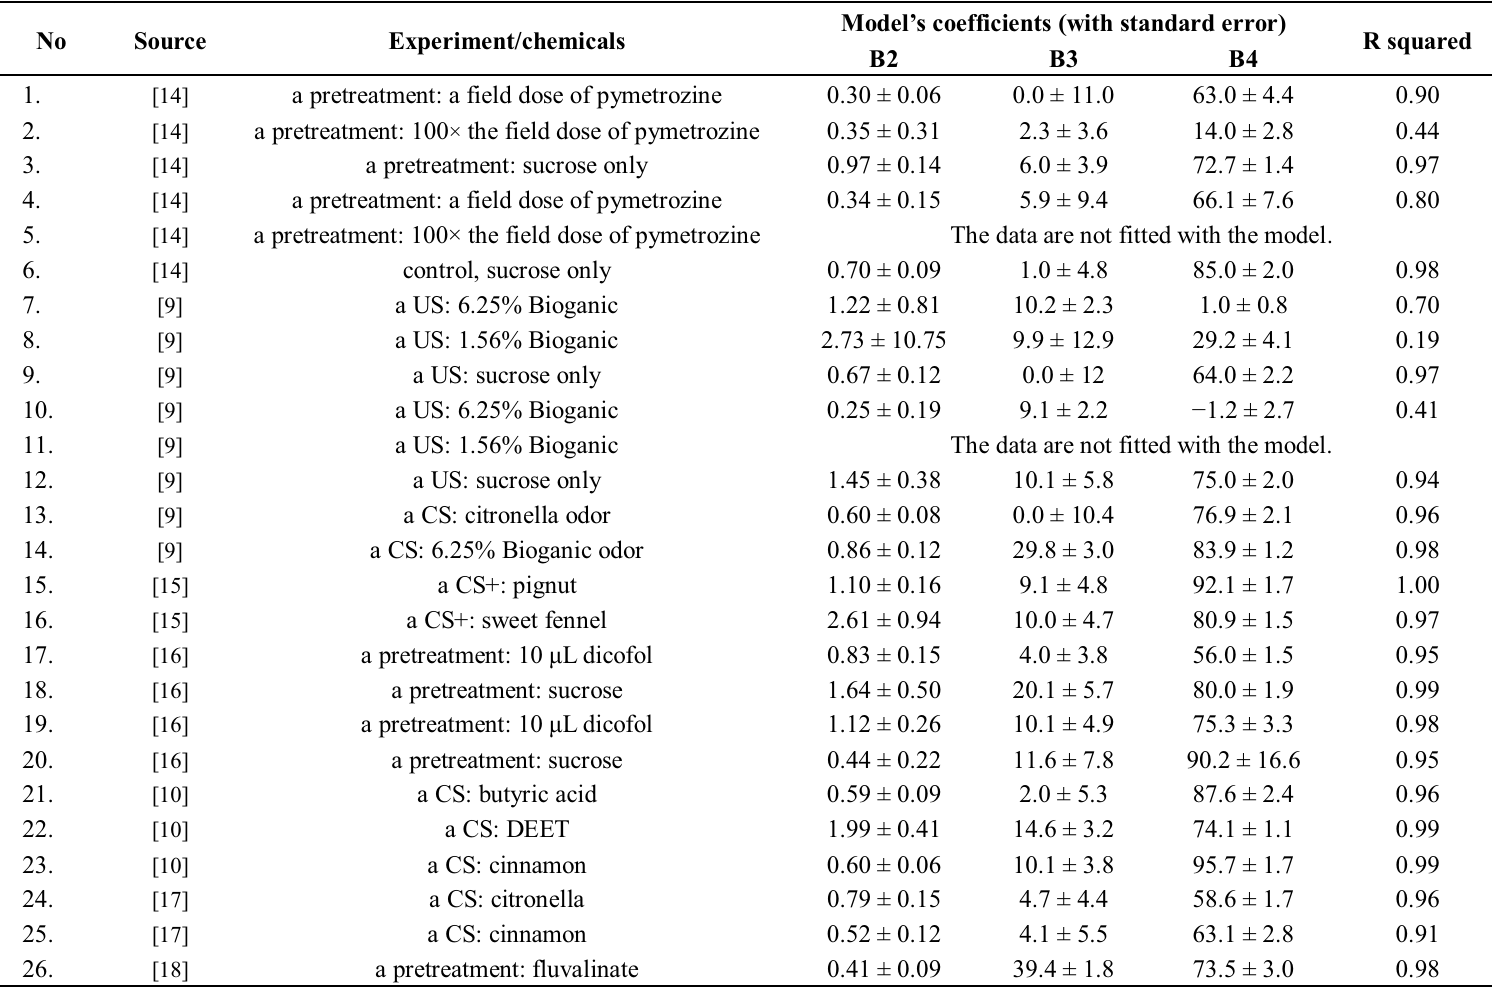
Table 2. Learning curve modeling. The data from Table 1 are analyzed below and coefficients are listed for B2, B3 and B4. The source listed is the original source of the data, and can be found in the